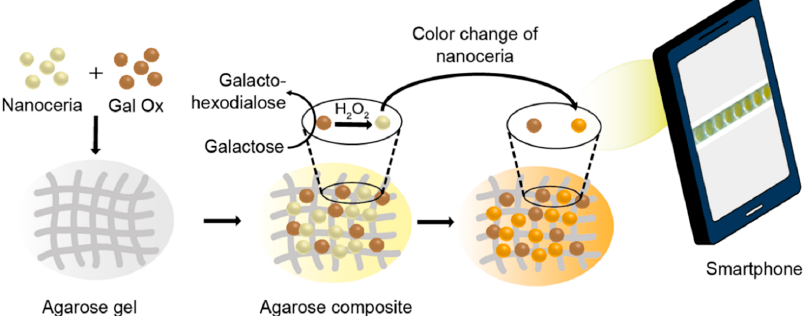
Figure 1. Schematic illustration of the agarose composite consisting of nanoceria and Gal Ox for the smartphone-mediated, reagent-free colorimetric determination of galactose.